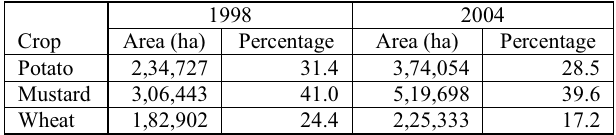
Table 3: Rabi crops